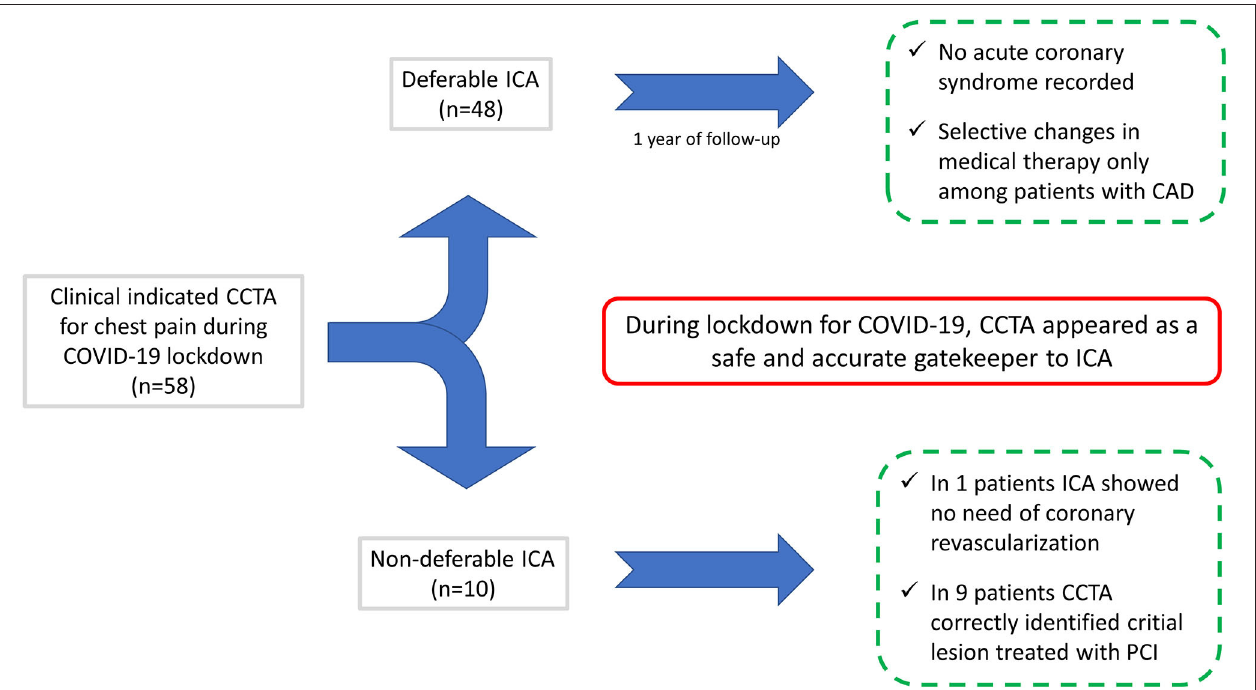
FIGURE 1 | Coronary computed tomography angiography (CCTA) enabled the correct detection of the selected patients who needed non-deferrable treatment, while safely ruling out the critical coronary stenoses in 48 out of 58 patients who were free of the cardiovascular events at follow-up. CCTA, coronary computed tomography angiography; ICA, invasive coronary angiography; PCI, percutaneous coronary